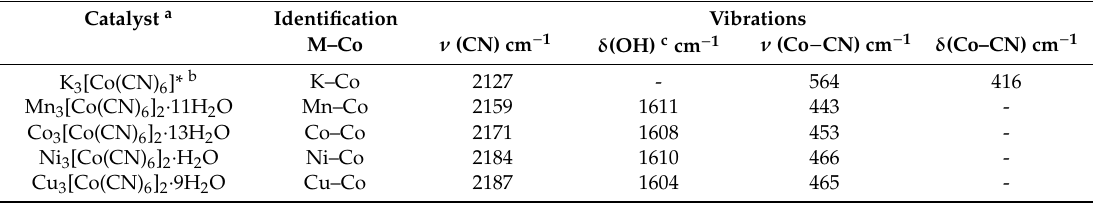
Figure 2. Infrared (IR) spectra of ( A ) K 3 [Co(CN) 6 ], ( B ) Mn–Co, C) Co–Co, D) Ni–Co, E) Cu–Co catalysts. Table 1. Overview of synthesis identification. Table 1. Overview of synthesis